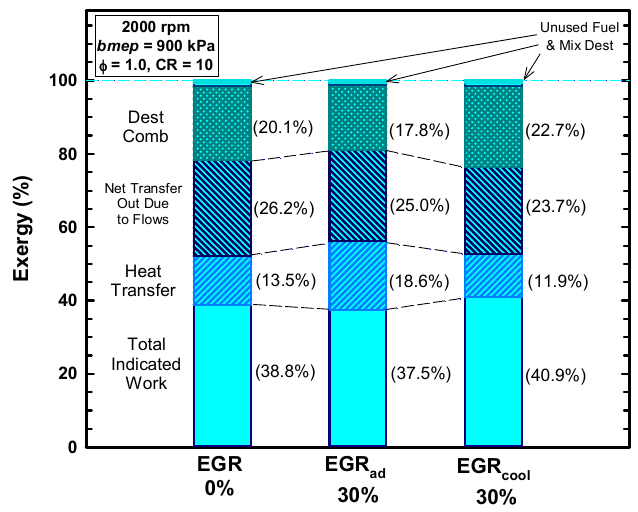
Figure 19. The partition of the fuel exergy for three cases: 0% EGR, 30% EGR adiabatic, and 30% EGR